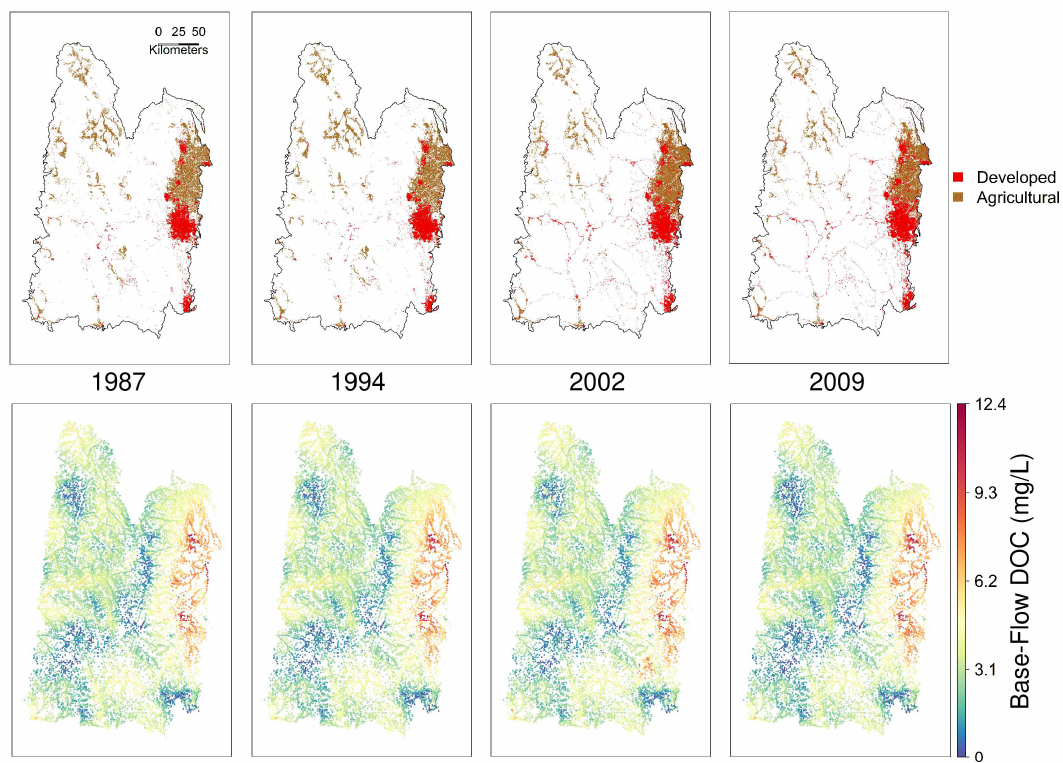
Figure 9. Comparison of developed and agricultural land cover with predicted base-flow DOC concentrations in the region of interest for the years 1987, 1994, 2002, and